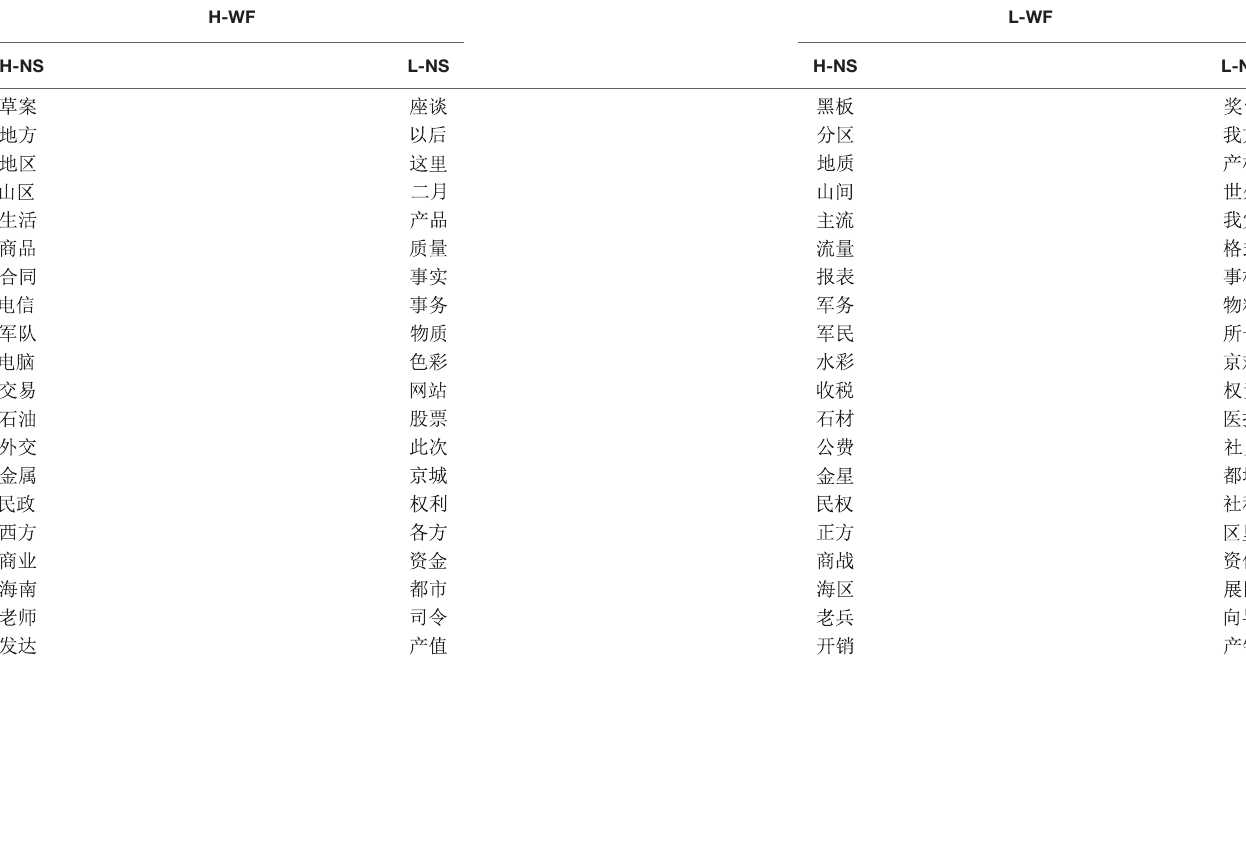
TABLE A1 | Target words under four